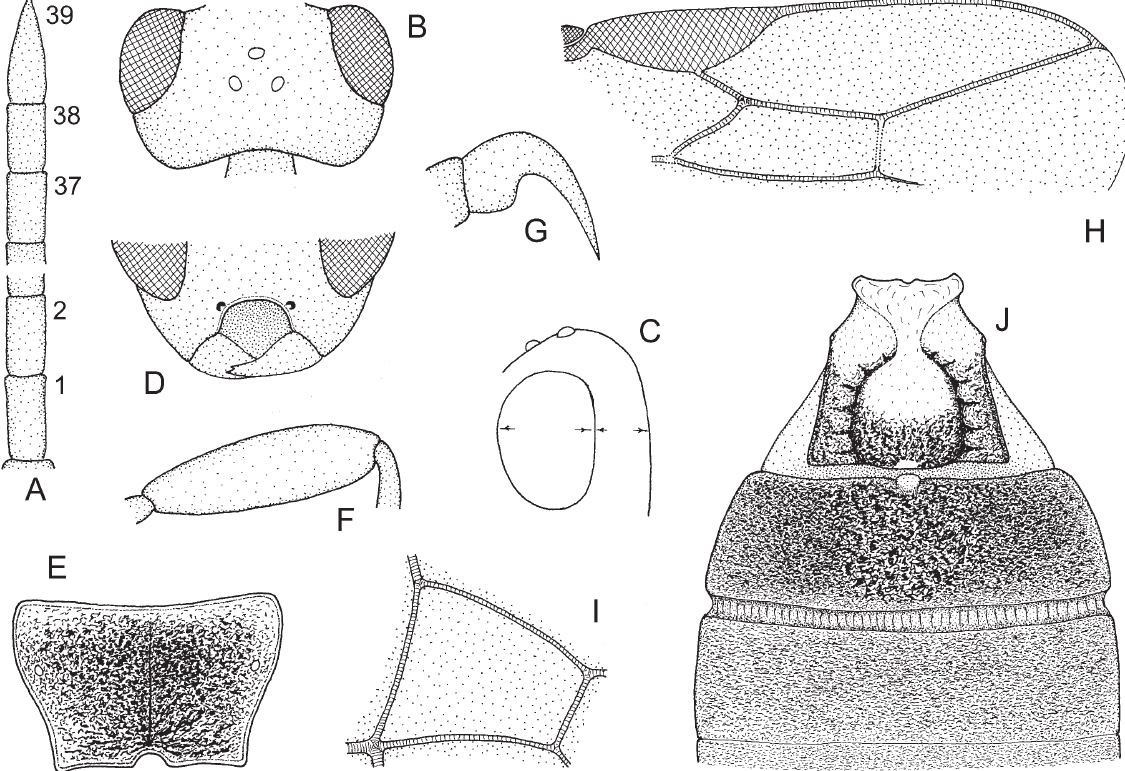
Fig. 60. Bracon ( Bracon ) fulvipes Nees, 1834, ♀ neotype. A . First two and ultimate three flagellomeres. B . Head in dorsal view. C . Head in lateral view. D . Head in frontal view. E . Propodeum. F . Hind femur. G . Claw. H . Distal part of right forewing. I . First discal cell of right forewing. J . Tergites